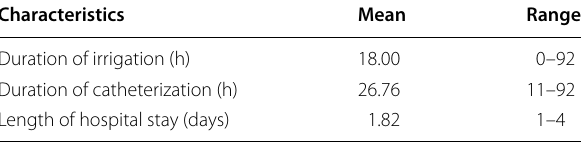
Table 2 Peri-operative